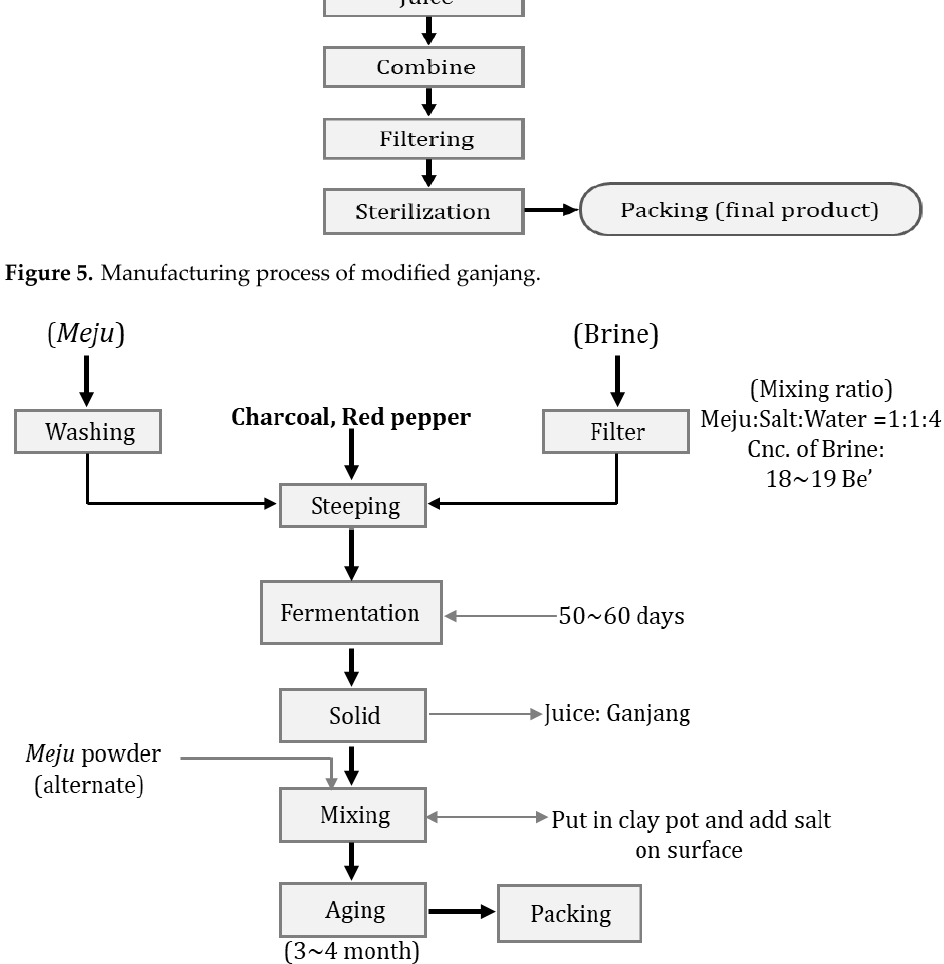
Figure 7. Modified doenjang preparation process . 2.2.4. Gochujang Gochujang is a unique seasoning, and it is not only an item that can store well, but is also a spice-fermented seasoning that is differentiated due to its originality, such as its